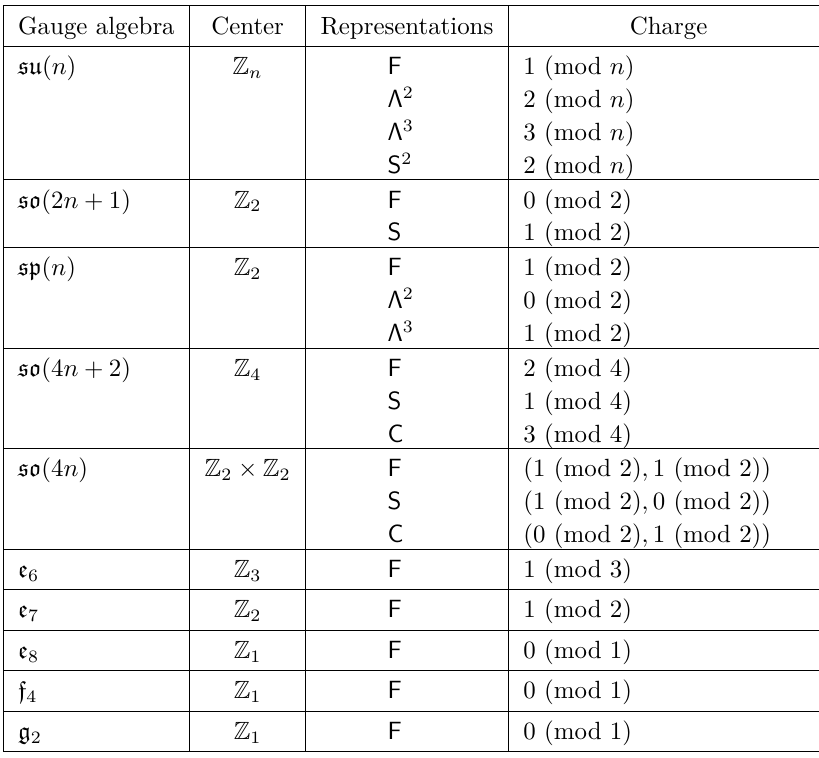
Table 1 . Centers of various gauge algebras and charges of some of the representations under the center of the gauge algebra. The adjoint representation A is not mentioned in the table above since it always has charge 0 under the corresponding center. F denotes the fundamental representation for su ( n ) , sp ( n ) ; the vector representation for so ( n ) ; and the irreducible representations of dimensions 7 , 26 , 27 , 56 for g 2 , f 4 , e 6 , e 7 respectively. We often refer to F as the “fundamental representation” of the corresponding algebra. Λ 2 and Λ 3 denote the irreducible two and three index antisymmetric representations for su ( n ) and sp ( n ) . S 2 denotes the two-index symmetric irrep for su ( n ) . S and C denote the irreducible spinor reps of different chirality for so (2 n ) ; and S denotes the irreducible spinor rep for so (2 n +1) . The charges for arbitrary irreps are provided in equations (3.46) and (3.47).